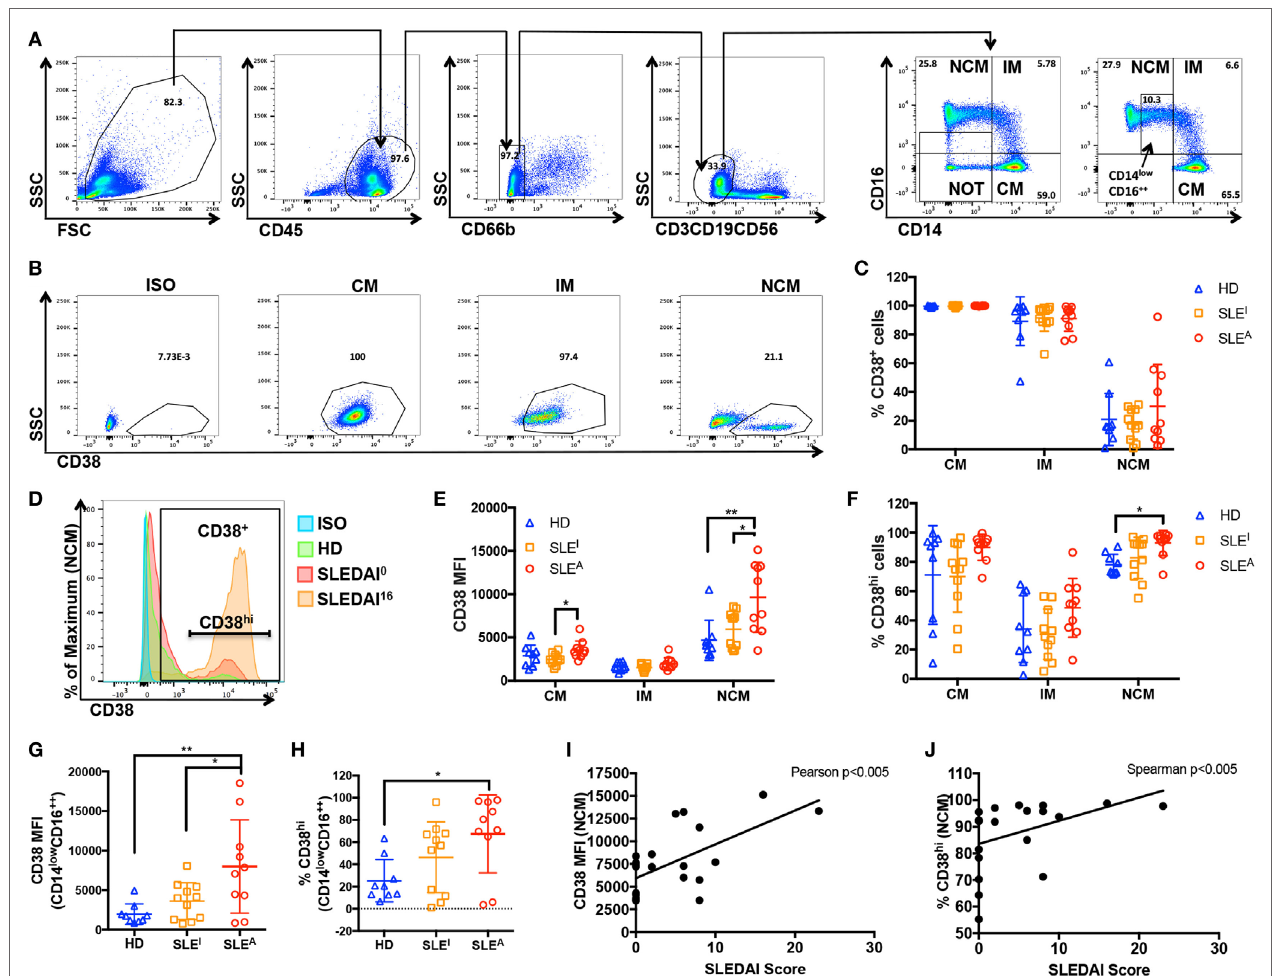
FigUre 4 | CD38 mean fluorescence intensity (MFI) in non-classical monocytes (NCMs) is elevated in active systemic lupus erythematosus (SLE). (a) Gating strategy: peripheral blood mononuclear cells isolated from healthy donors (HD) or SLE patients (panel 1) were gated for CD45 + cells (panel 2) prior to gating out CD66b − cells (panel 3) and CD3 − CD19 − CD56 − (panel 4) cells. The remaining population was analyzed with CD14 and CD16 after removing cells that are neither CD14 + nor CD16 + (NOT gate) (panel 5) to identify classical (CD14 ++ CD16 − ) (CM), intermediate (CD14 + CD16 + ) (IM) and non-classical (CD14 + CD16 + )